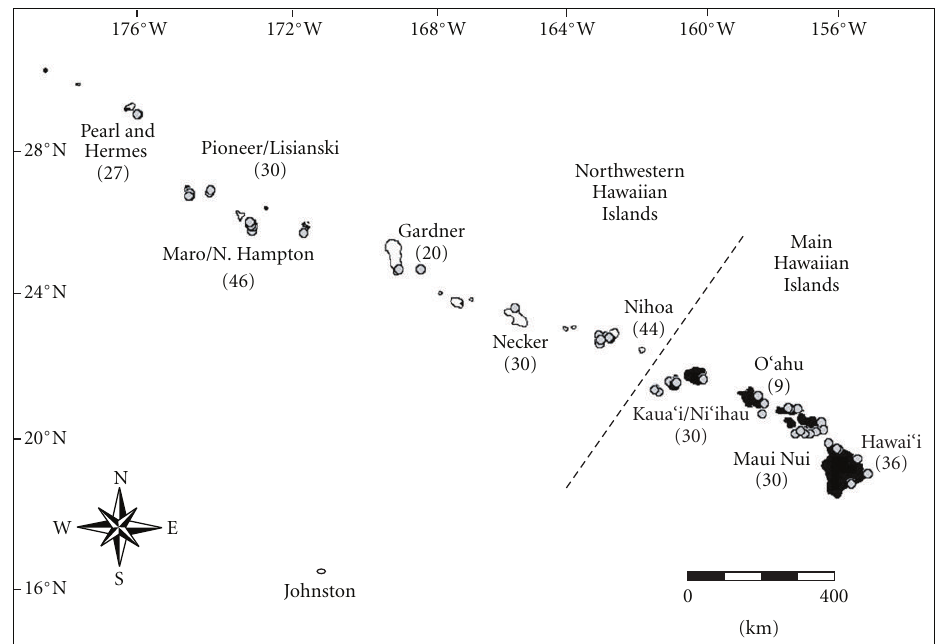
Figure 1: Sample locations and numbers of specimens of Epinephelus quernus collected across the Hawaiian Archipelago.